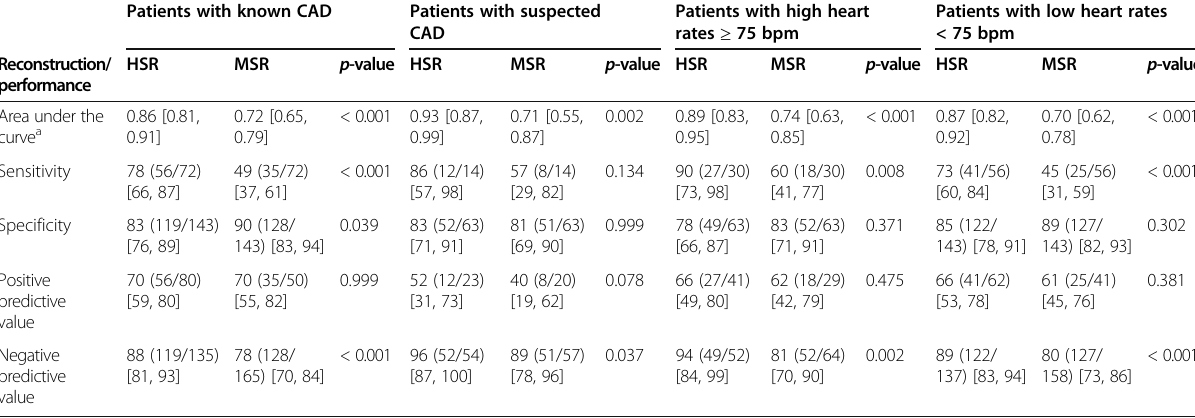
Table 5 Patient subgroups in per-territory level analysis: diagnostic performance of MSR and HSR of myocardial CTP Patients with known CAD Patients with suspected Patients with high heart Patients with low heart rates CAD rates ≥ 75 bpm < 75